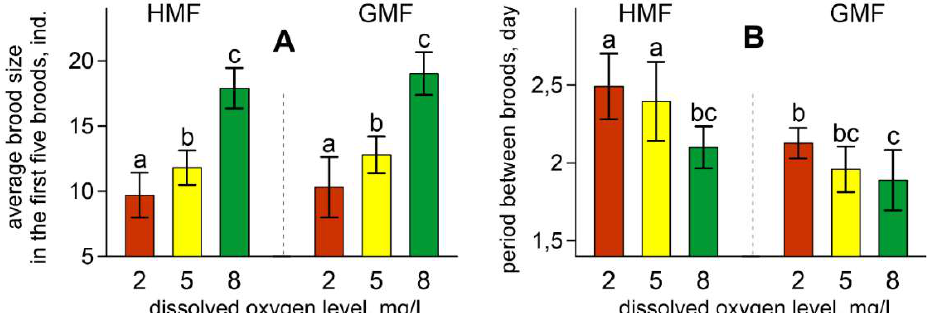
Figure 3. Average brood size in the first five broods ( A ) and the period between broods ( B ) in studied groups of daphnids. Values are means ± standard deviation. Different letters indicate significant differences among groups ( p < 0.05) ( p < 0.05) after Tukey’s post-hoc multiple comparison tests ( A ) or Kruskal–Wallis test and Dunn’s post-hoc test ( B ). For all variables with the same letters, the difference between the groups is not statistically significant. Significantly different groups have different letters.